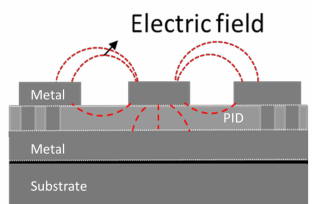
Figure 16. Definition of algebra in the impedance equation.